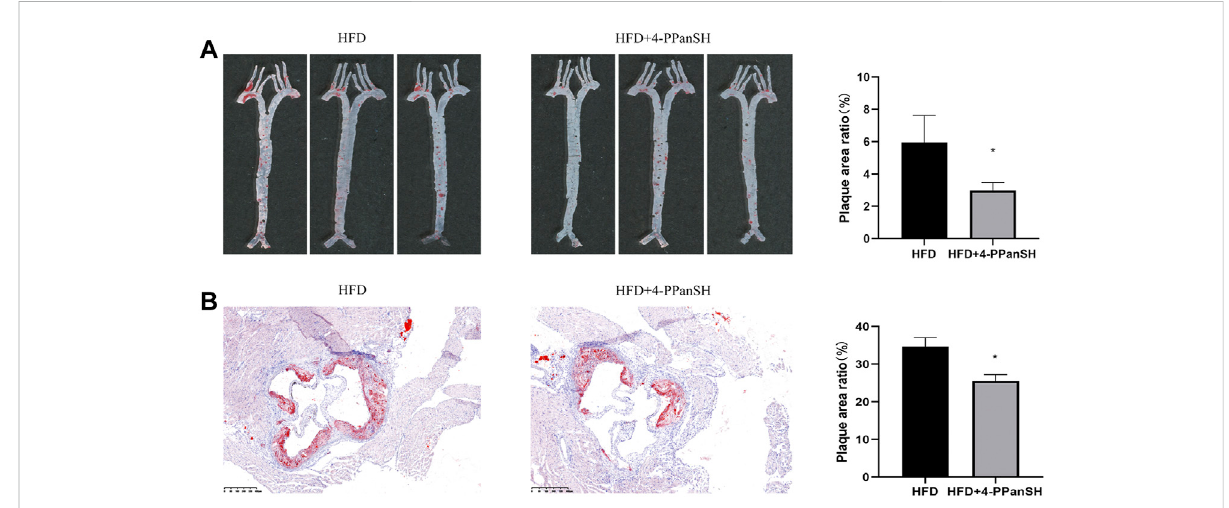
FIGURE 4 4-PPanSH could attenuate the formation of AS plaques. (A) The abdominal aortas of mice were stained with oil red O ( n = 3). 4-PPanSH could signi fi cantly inhibit AS plaque formation inmice. (B) 4-PPanSH could alleviate aortic rootlesions in mice ( n = 3).*Indicates p < 0.05 compared to the HFD